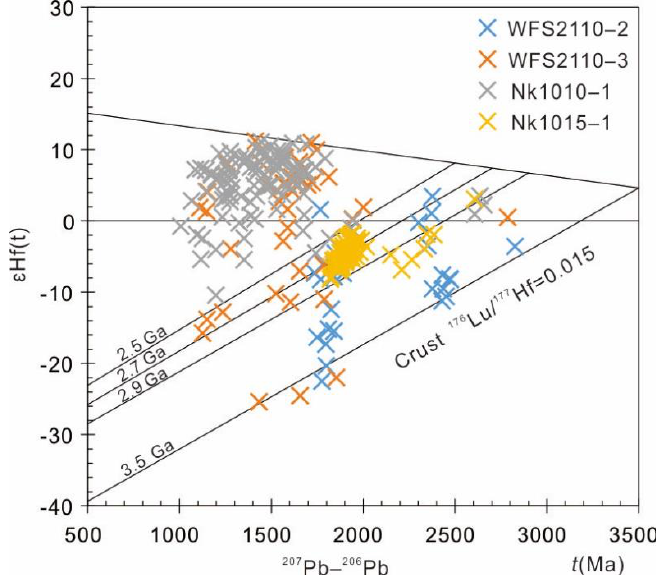
Figure 7. Hafnium isotope characteristics of detrital zircons of the samples from the target successions.